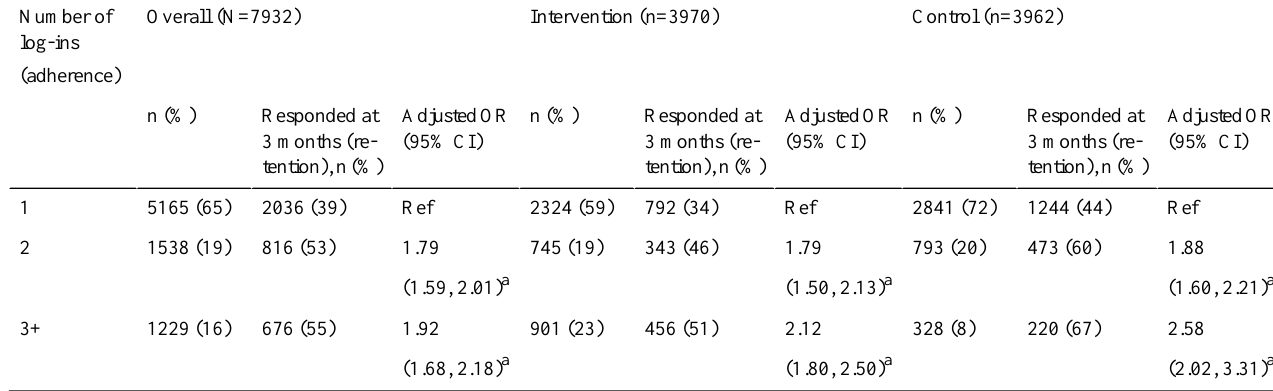
Table 2. Adherence and